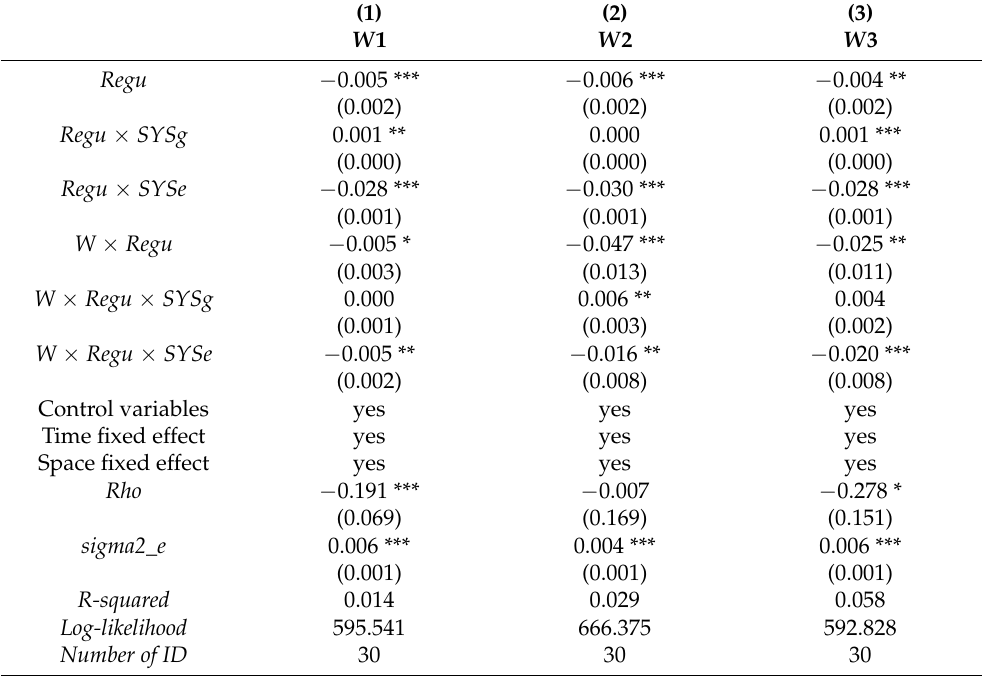
Table 15. Performance appraisal effect test.